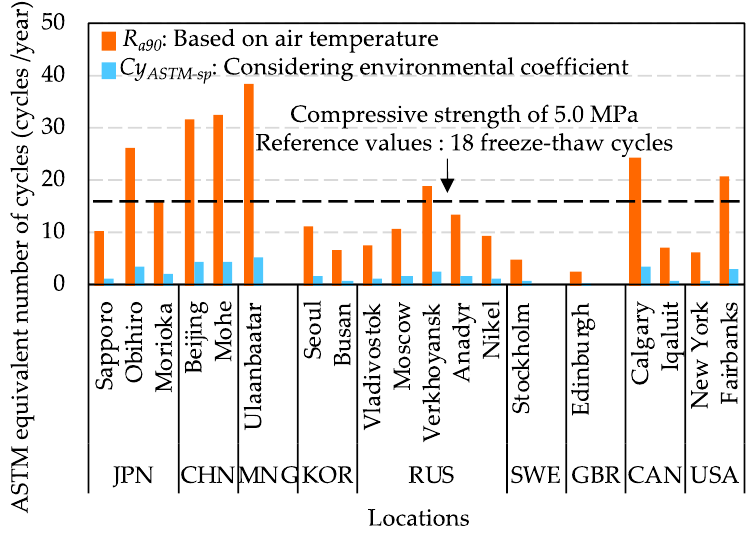
Figure 11. 𝑅 𝑎90 and 𝐶𝑦 𝐴𝑆𝑇𝑀−𝑠𝑝 results of various locations. Figure 11. R a 90 and Cy ASTM − sp results of various